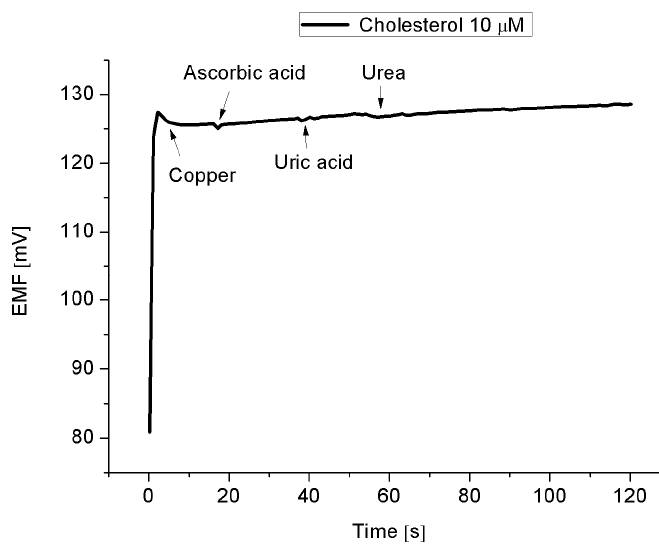
Figure 8. Repeated experiments for eleven days during three weeks in a 10 × 10 − 6 M cholesterol solution using same electrode.